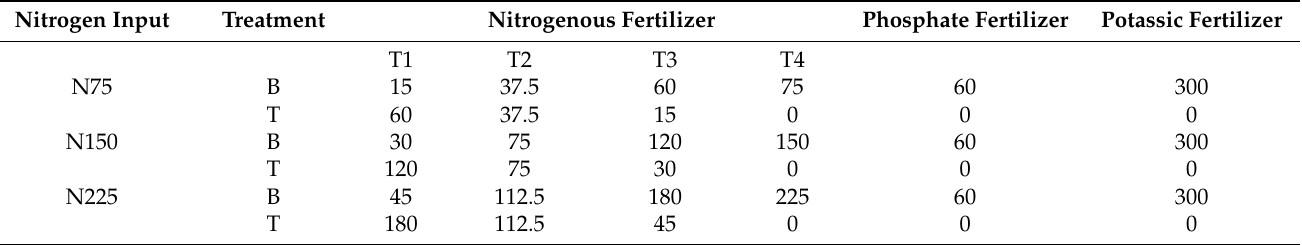
Table 1. Fertilizer application amount and nitrogen fertilizer based/topdressing ratio (kg ha − 1 ). Nitrogen Input